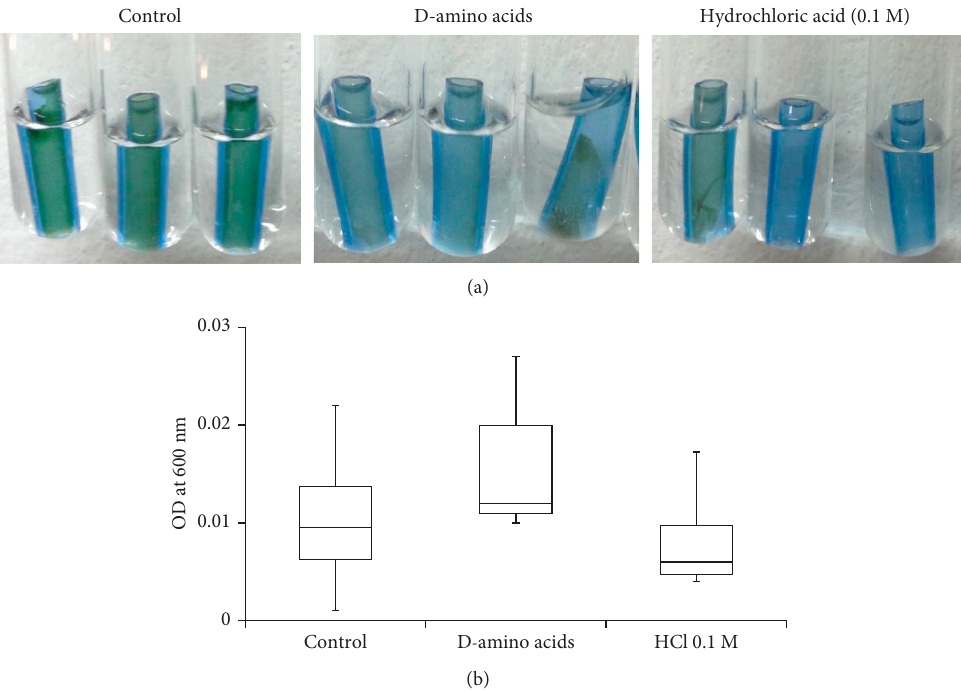
Figure 2: 2.5 mm pieces of DUWL tube after incubation with distilled water, D-amino acids mixture (10mM each), or 0.1M hydrochloric acid (dissolvent control) for 5 days (a). Optical density at 600nm (OD 600 ) of dispersed biofilms in flushing water collected after the 2.5mm pieces of DUWLs were incubated with distilled water, D-amino acids mixture (10mM each), or 0.1M HCl (dissolvent control) for 5 days (b).